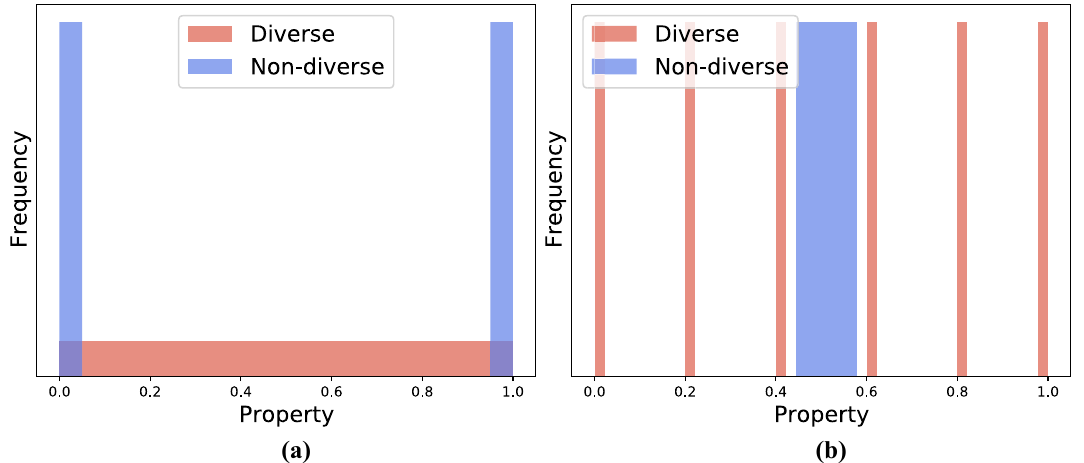
Figure 3. Graphical explanation of why the ( a ) variance and ( b ) Kullback–Leibler (KL) divergence are inappropriate. In ( a ), the variance of a diverse set (red) is smaller than that of a non-diverse set (blue), which does not suit our idea of diversity. In ( b ), the KL divergence of a diverse set (red) is equal to that of a non-diverse set